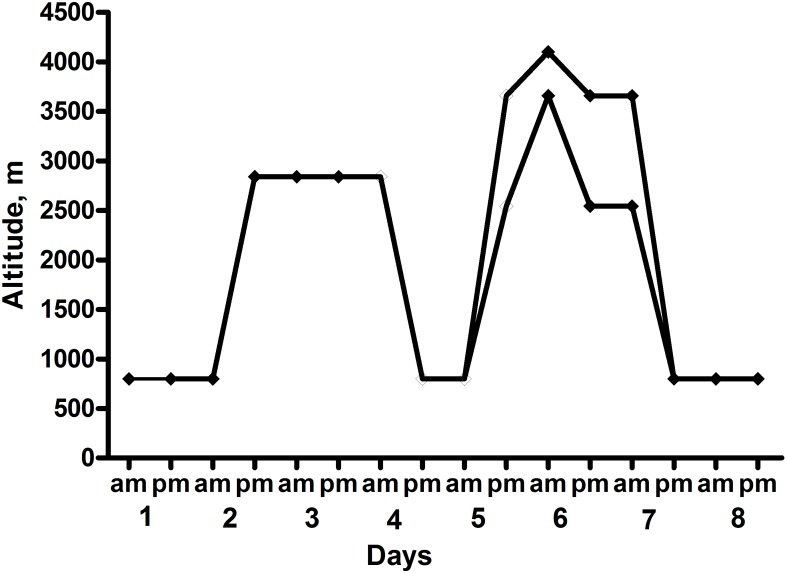
Ascent Profile of the subjects. Heart rate variability (HRV) recordings were taken at 0200–0300 each night.